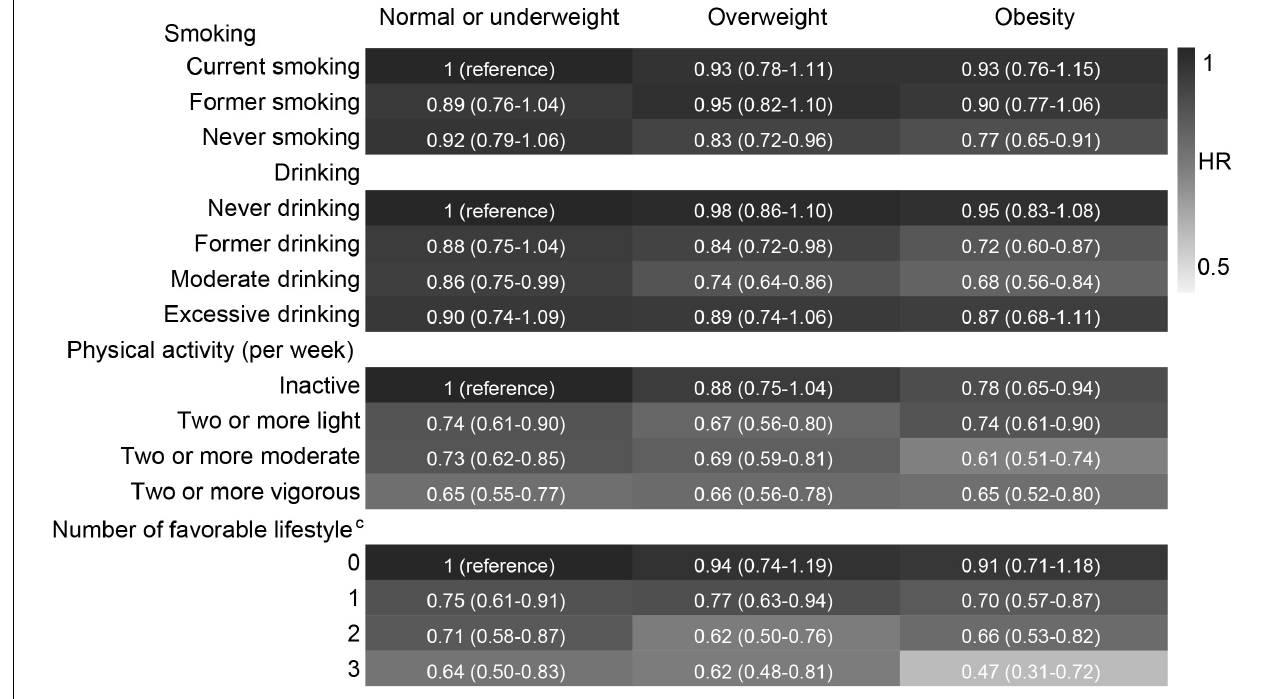
FIGURE 7 | Risk of cognitive impairment according to the combination of lifestyle and body weight status. HRs (95% CIs) were presented: light grey means protective. The model adjusted for smoking, drinking, physical activity, age, sex, education, marriage, family wealth per capita, and PRS for BMI. c Moderate drinking was considered favourable. The significance level was set at α =